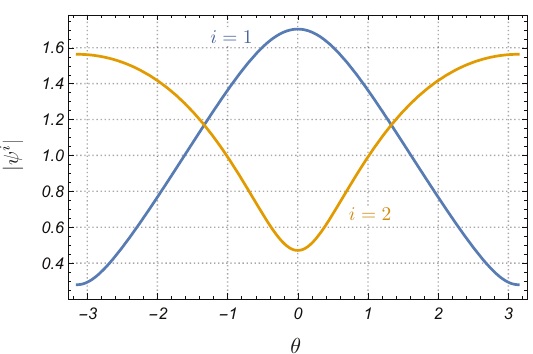
i at l = 0 : 9 on S 2 with three branes. Since j j